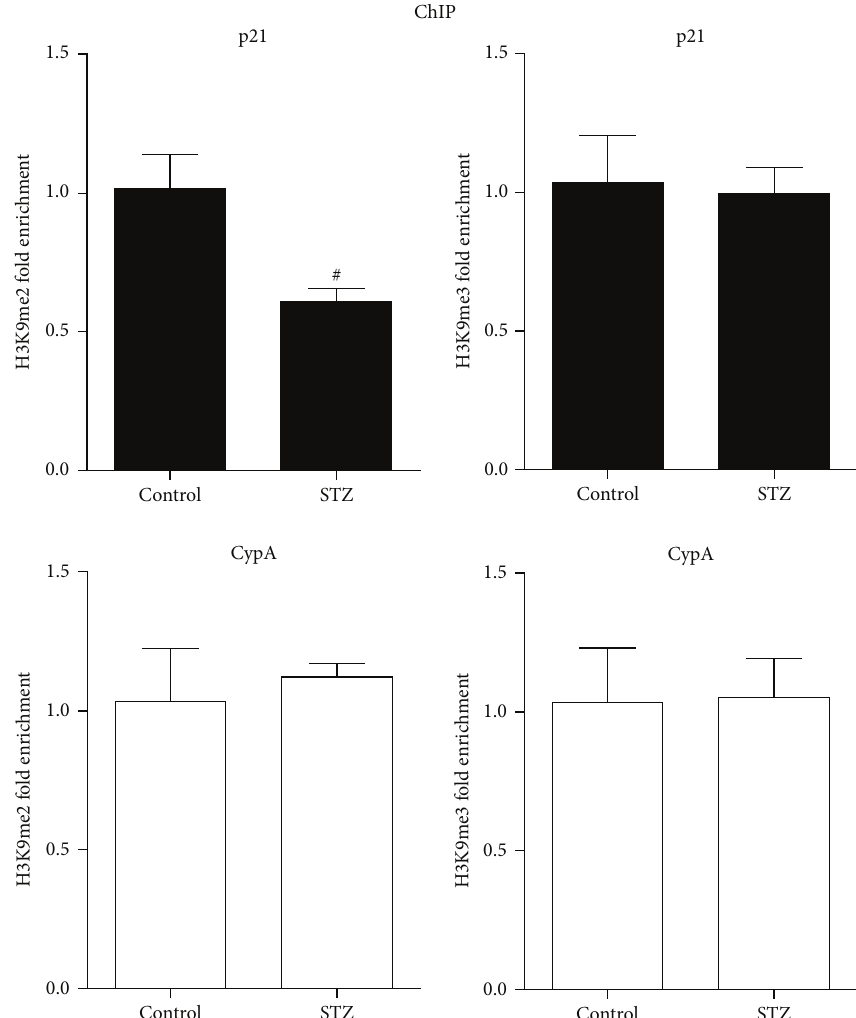
Figure 2: H3K9me2/3 levels at p21 gene promoter in the glomeruli of type 1 diabetic rats. Bar graphs showing H3K9me2 and H3K9me3 levels at p21 and CypA promoters in glomeruli of control and STZ groups. ChIP assays were performed with H3K9me2 and H3K9me3 antibodies, immunoprecipitated DNA and input DNA were subjected to RT-qPCR with primers for the respective promoter, data were analyzed by the 2 −ΔΔ Ct method, and results normalized to input DNA were expressed as fold over the control group (mean ± SEM; # 𝑃 < 0.05 compared to control, 𝑛 = 6